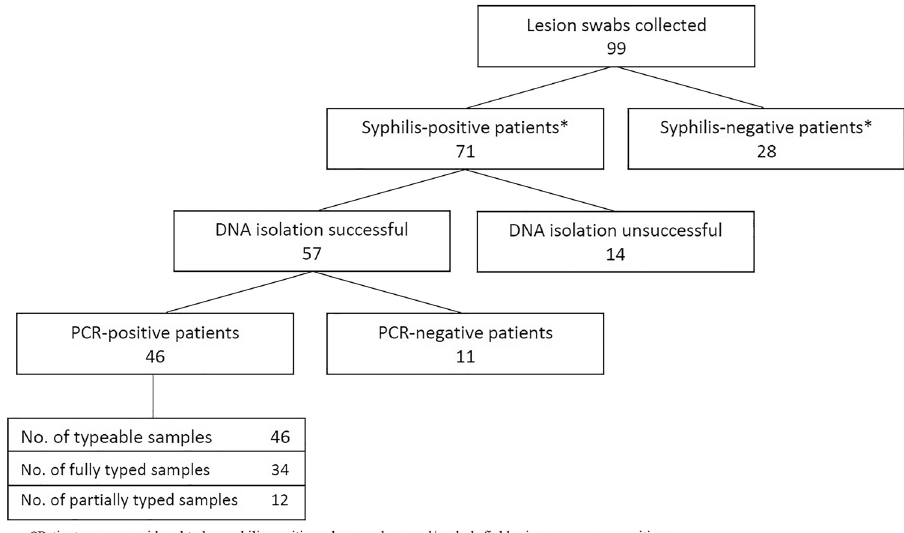
Figure 1. Flow chart of samples collected and analyzed in this